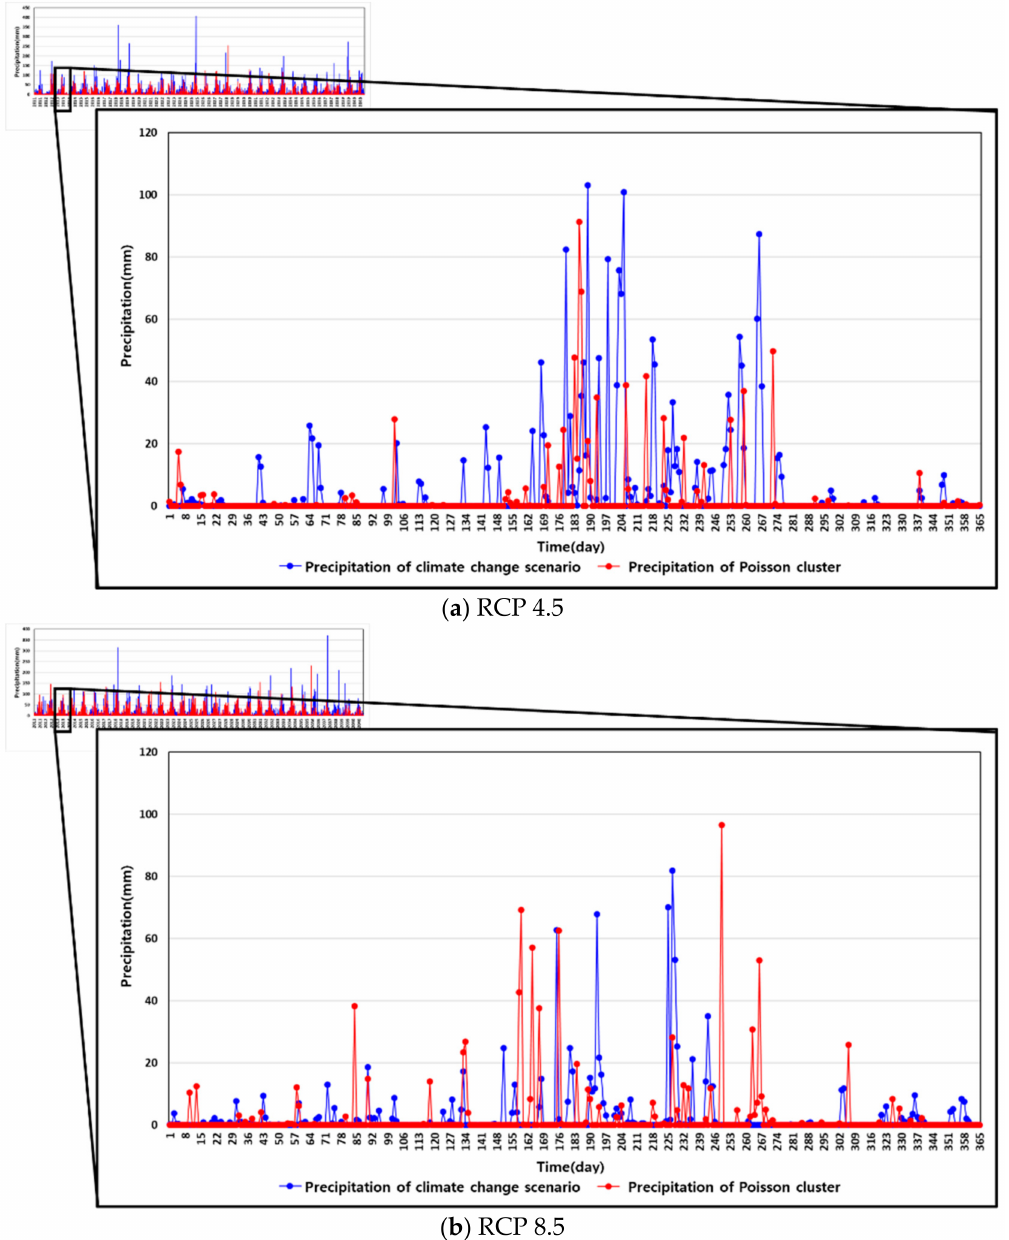
Figure 4. Time series of rainfalls from the HadGEM2-ES for Cheongju